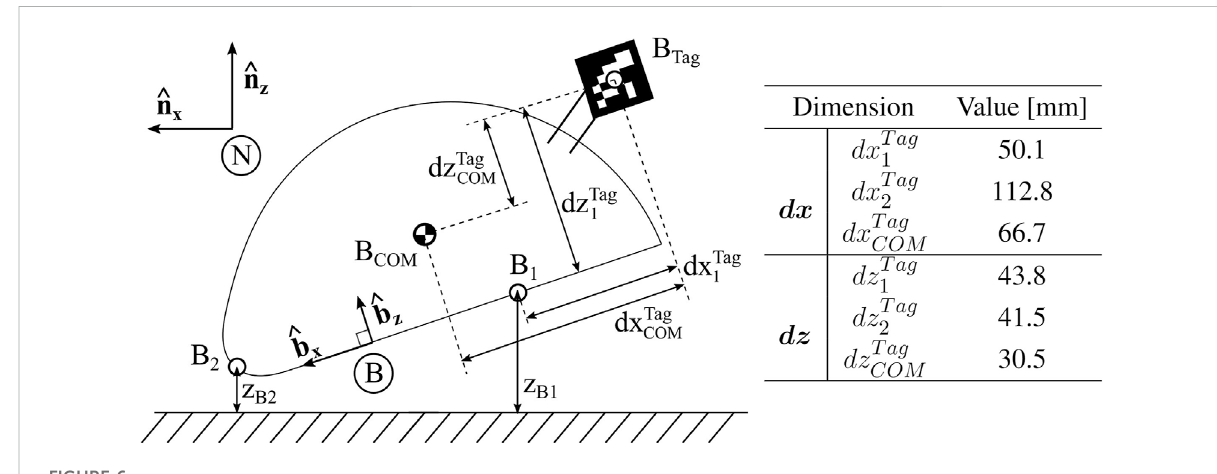
FIGURE 6 Robot Parameter De fi nitions. De fi nition of coordinate frames, including Newtonian frame N and body frame (B) . Relative distances between de fi ned points on the robot body are